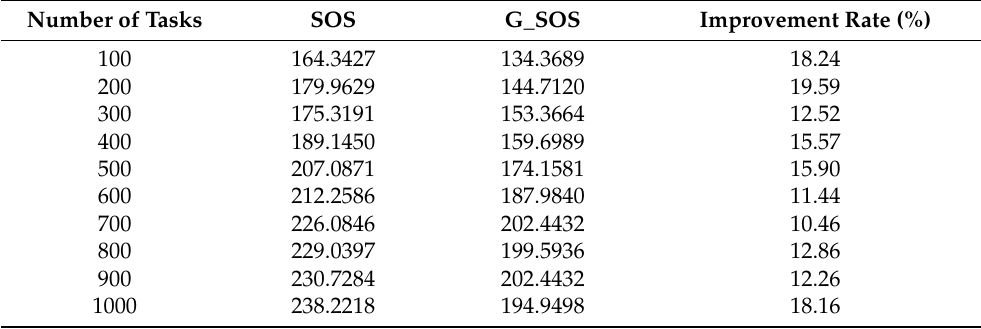
Table 6. Cost comparison between SOS and G SOS for data instances generated from a uniformly distributed dataset.